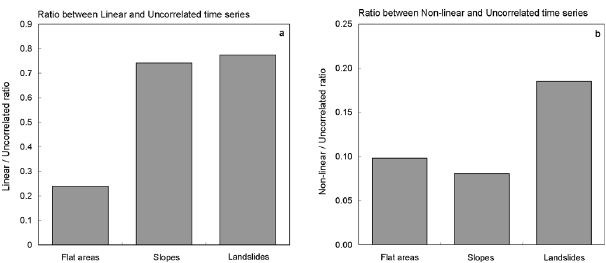
Fig. 10. Relative frequency of linear (a) and non-linear (b) time series with respect to uncorrelated time series in the three morpho- logical units mapped in the study